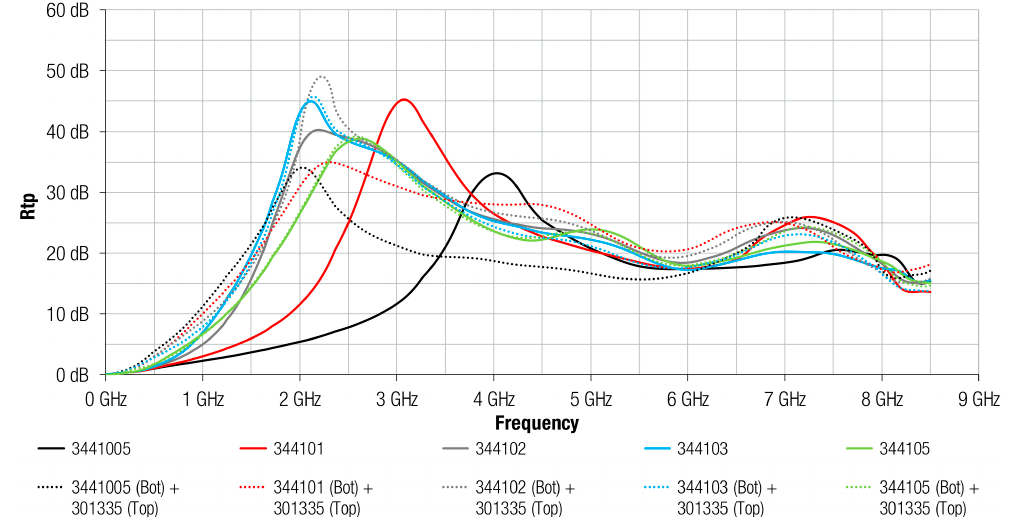
Figure 8. (cid:1844) (cid:3047)(cid:3043) of 3441 absorber material with different thicknesses and Al layer integrated.